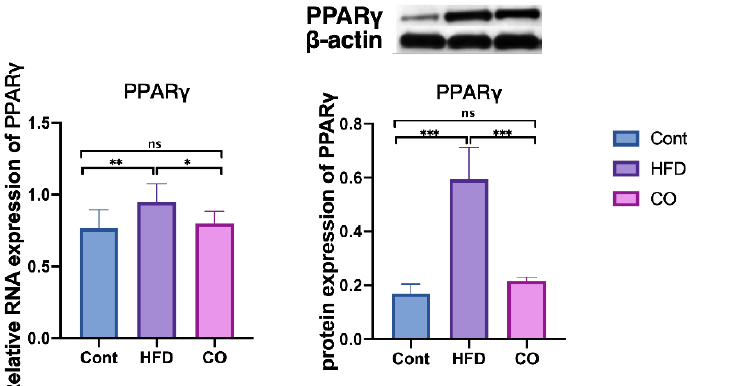
Figure 3. Effect of CO treatment on serum levels of PPAR γ in HFD-fed mice. Data are expressed as the mean ± SEM ( n = 10), * p < 0.05, ** p < 0.01, *** p < 0.001, ns p > 0.05.